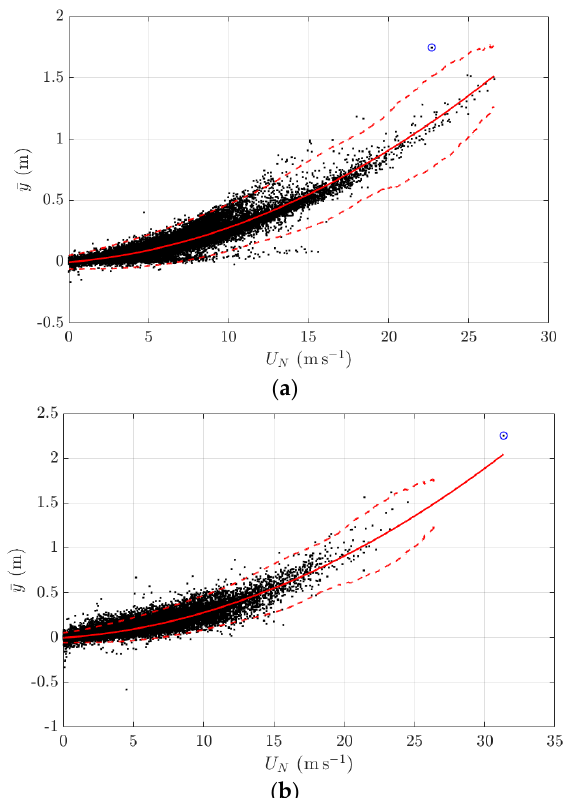
Figure 23. Variation of the mean lateral displacement at the mid span against the normal component of the mean wind speed in a comparison with the developed quadratic curve and thresholds; ( a ) 2015 and ( b ) 2016; extreme events are highlighted by blue circles.